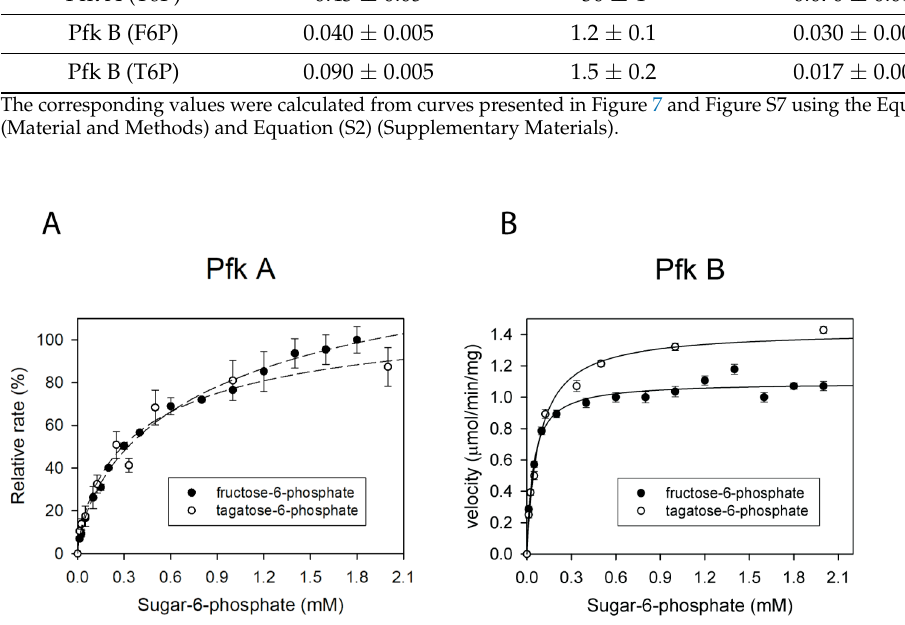
Figure 7. Utilization of different sugar-phosphates as substrates in the Pfk A and Pfk B reaction. ( A ) Coupled reaction mixture II without PEP containing 1 mM ATP and 30 nM Pfk A was aliquoted to individual microtiter plate wells containing increasing concentrations of the particular sugar-phosphate (0–2 mM F6P or T6P). Reactions were allowed to proceed for 5 min and subsequently PEP solution was pipetted into each well to reach 1 mM final concentration. 100% corresponds to the highest reaction rate (enzyme activity) achievable. Dashed lines indicate the increasing trend. ( B ) Coupled reaction mixture II with 1 mM ATP and 300 nM Pfk B was aliquoted to individual microtiter plate wells containing increasing concentrations of the particular sugar-phosphate (0–2 mM F6P or T6P). The data were fitted to Equation (1).